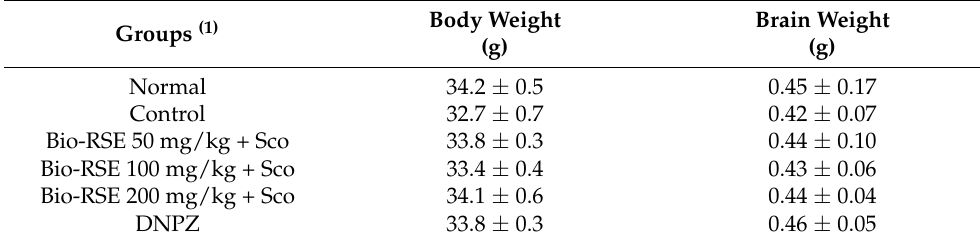
Table 3. Body weight and brain weight of mice. Groups (1)